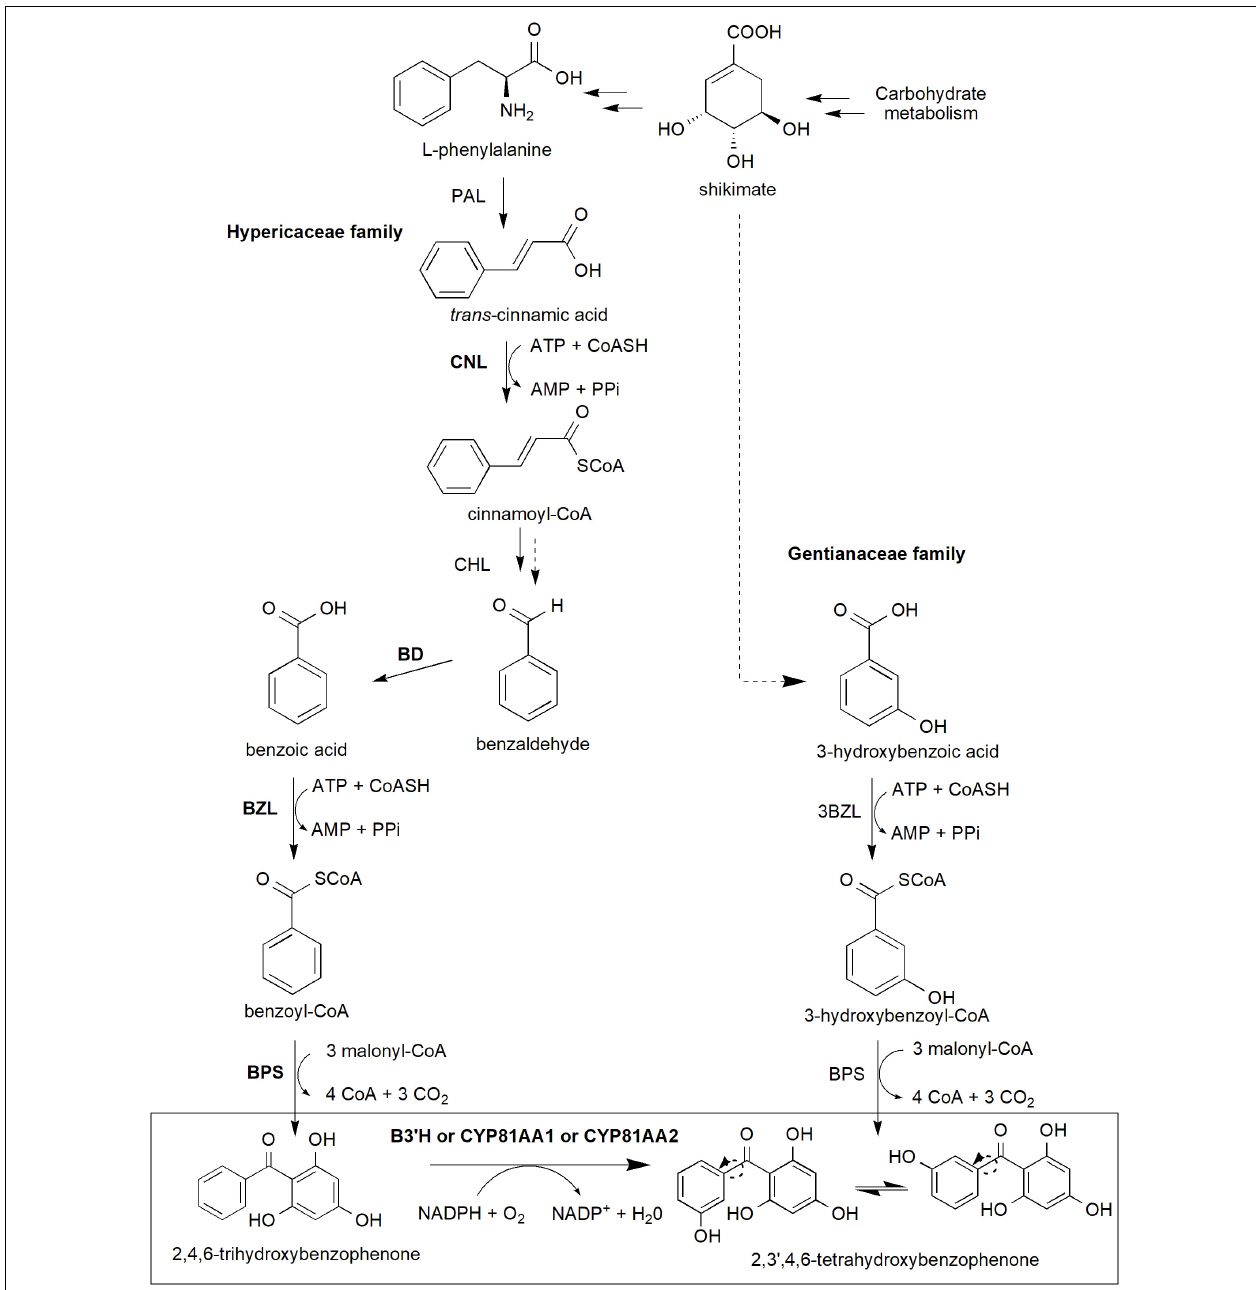
FIGURE 2 | The core xanthone biosynthesis pathway in plants. The shikimate pathway supplies shikimate and L -phenylalanine precursors (detailed pathway is provided in Supplementary Figure 1 ) to produce benzophenone intermediates, in particular 2,3 (cid:48) ,4,6-tetrahydroxybenzophenone isomers used for downstream xanthone biosynthesis. In Gentianaceae family, 3-hydroxybenzoic acid is formed from shikimate and subsequently to 3-hydroxybenzoyl-CoA and later 2,4,5 (cid:48) 6-tetrahydroxybenzophenone. Meanwhile, Hypericaceae family utilizes L -phenylalananine-dependent pathway through several more reactions to produce 2,4,6-trihydroxybenzophenone and later the 2,3 (cid:48) ,4,6-tetrahydroxybenzophenone. This latter reaction requires B3 (cid:48) H activity of which can be catalyzed by both CYP81AA1 or CYP81AA2 enzymes in Hypericum. Multiple arrows indicate multiple steps between intermediates while dotted arrows indicate hypothesized/proposed pathways. Protein activities that have been detected at molecular level are shown in bold while normal font type indicates protein activities detected at biochemical level (refer to Table 1 ). The two arrows (one unbroken line and one dotted) for Cinnamoyl-CoA hydratase/lyase (CHL) indicate that the enzymatic reaction has been characterized at the biochemical level from a crude protein extract, but whether this involves one or two enzymatic steps is yet to be validated at the molecular level. 3BZL, 3-hydroxybenzoate-CoA ligase; ATP, adenosine triphosphate; AMP, adenosine monophosphate; BD, benzaldehyde dehydrogenase; BZL, benzoate-CoA ligase; B3 (cid:48) H, benzophenone 3 (cid:48) -hydroxylase; BPS, benzophenone synthase; CHL, cinnamoyl-CoA hydratase/lyase; CNL, cinnamate-CoA ligase; CoASH, coenzyme A; NADPH, reduced nicotinamide adenine dinucleotide phosphate; PAL, phenylalanine ammonia-lyase; PPi, inorganic